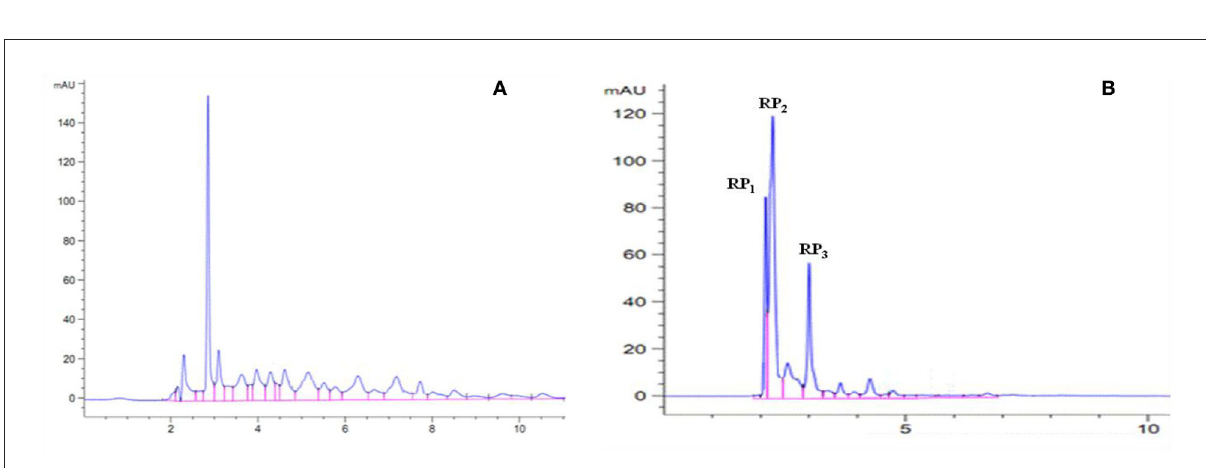
FIGURE7 Composition of PSKB protein hydrolysate. (A) The composition of the unpurified PSKB antioxidant peptide. (B) The composition of PSKB antioxidant peptides purified by XAD-7HP